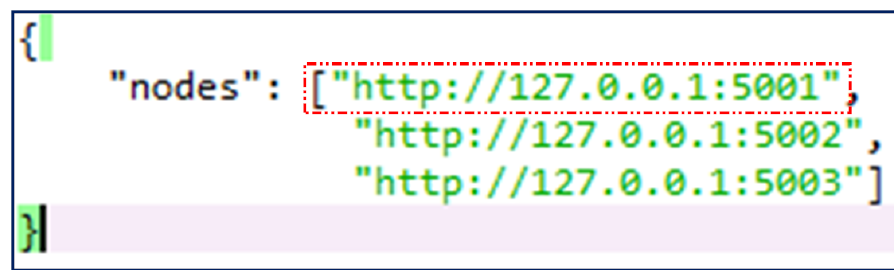
Figure A2. Different nodes of